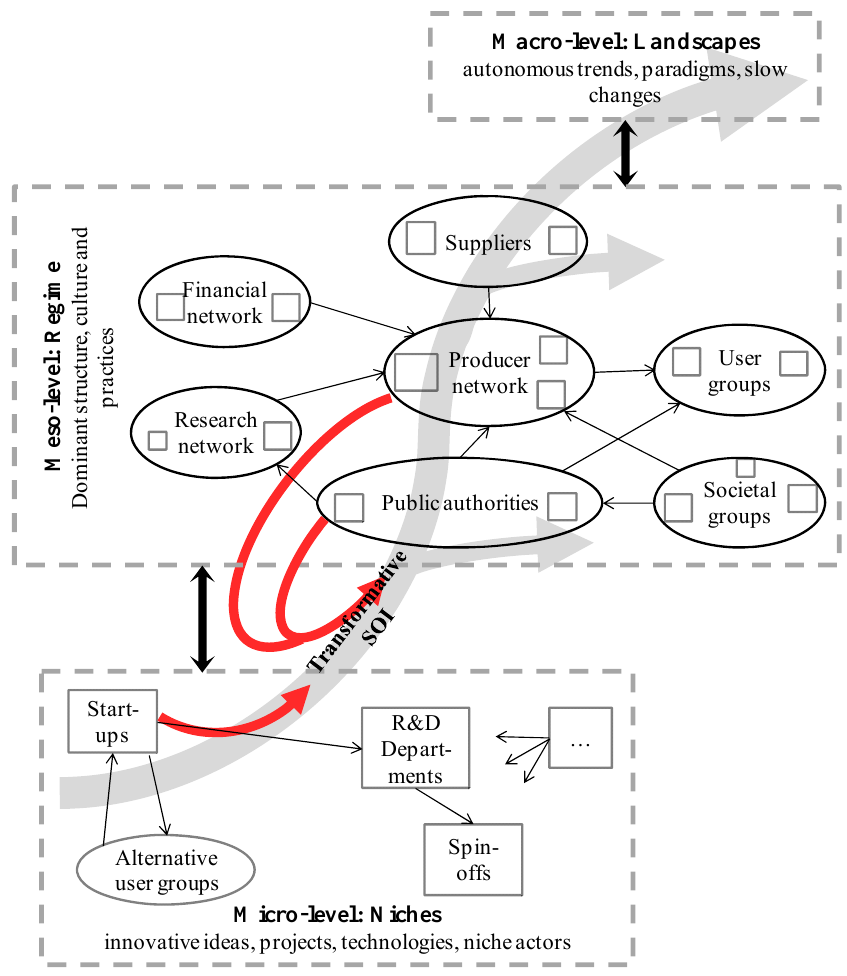
Figure 2. Actor perspective on the MLP framework. Notes: Own illustration based on Geels [31] (p. 1260) and Loorbach and Wijsman [4] (p. 23). The circles represent different groups of actors; the squares specific actors. The grey arrow in the background depicts a typical course of transitions. The red arrows show the potential influences of exemplary actors on pushing or pulling SOIs. The boundaries of the three levels are shaded in grey to signal their